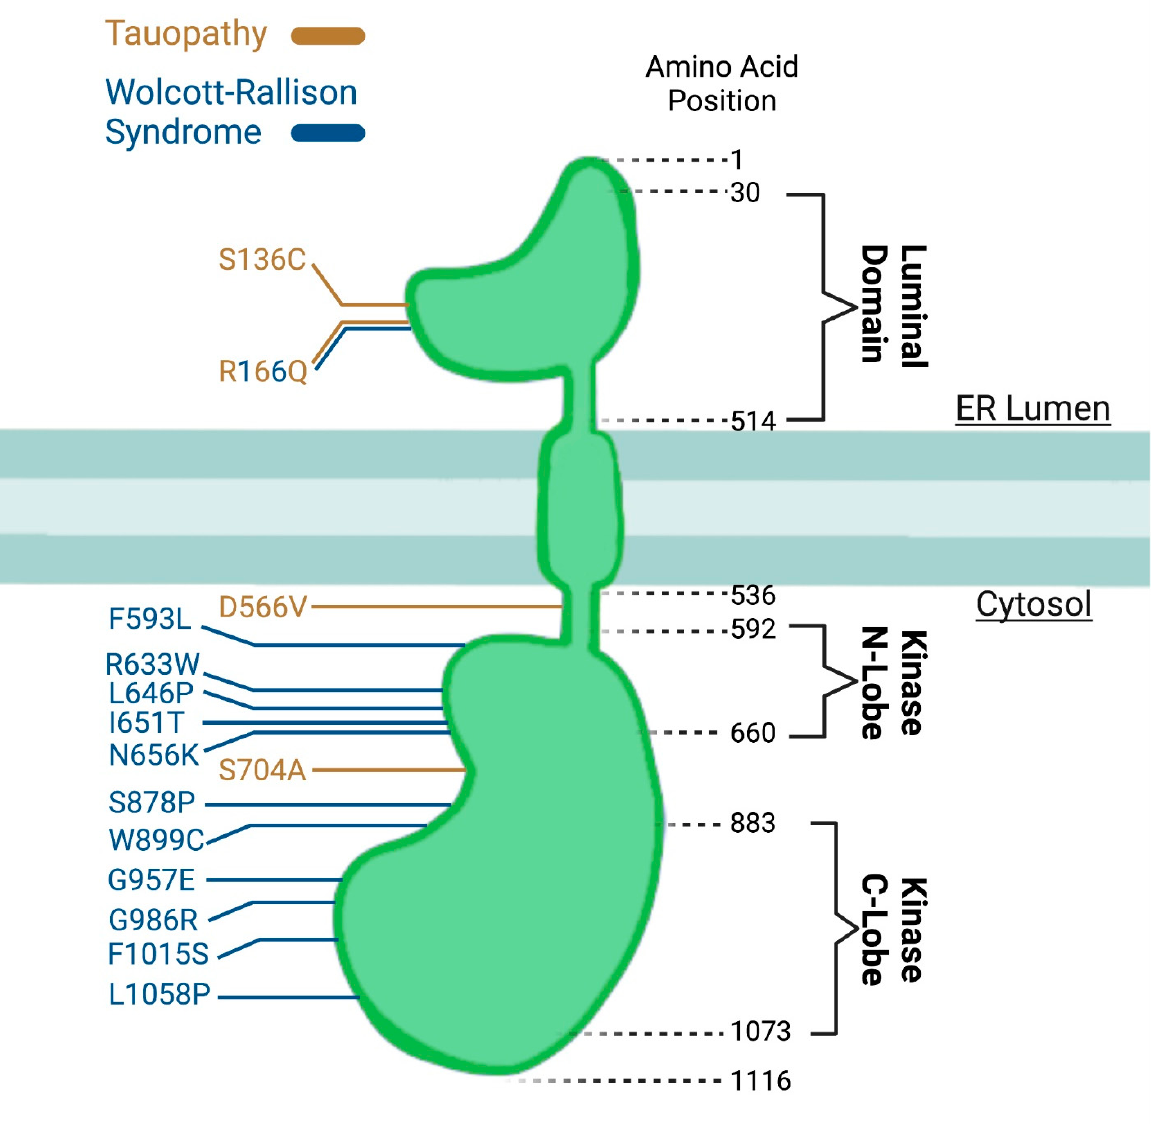
Figure 2. Pathology associated mutations of EIF2AK3 / PERK protein. Functional regions of the protein are indicated by amino acid positions with dashed lines (black) and colored amino acid numbers indicate tauopathy-related PERK Haplotype B SNPs (gold) and Wolcott-Rallison Syndrome variants (blue).